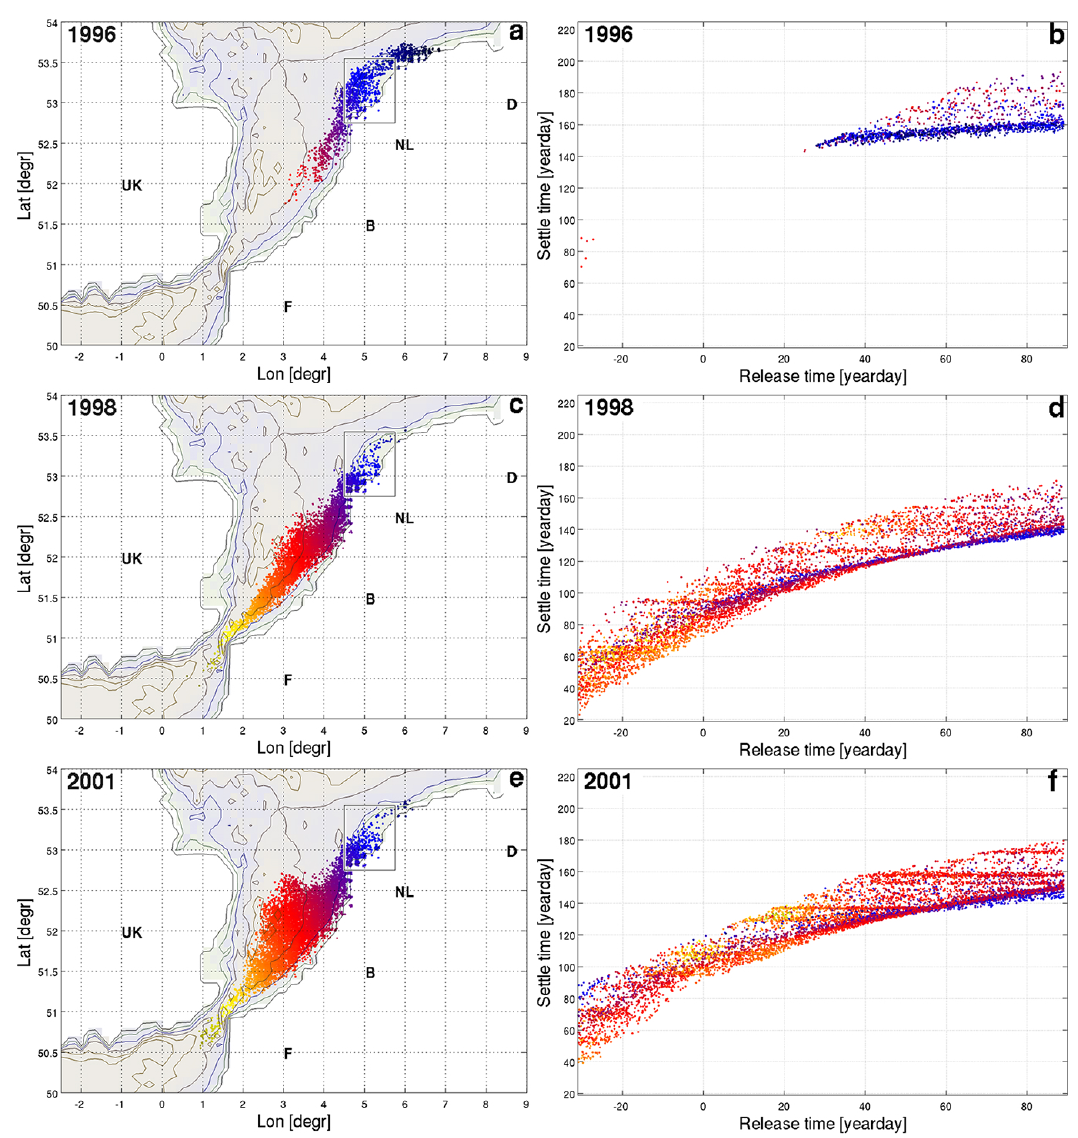
Figure 15. Particle settlement in the western Wadden Sea. (a, c, e) Release position of particles settling in the western Wadden Sea (shown as a black box). The colour of the dots represents the release position of the particles. (b, d, f) The drift duration, presented as the link between the release time and settle time of the particles. Colour coding is the same as in (a, c, e) . The curved bottom edge is the result of the development rate of the particles: colder temperatures in late winter (release time around yearday 30) result in prolonged development rates. The threshold at the top of the plots is primarily the result of the 30-day development threshold. (a, b) 1996; (c, d) 1998; (e, f)